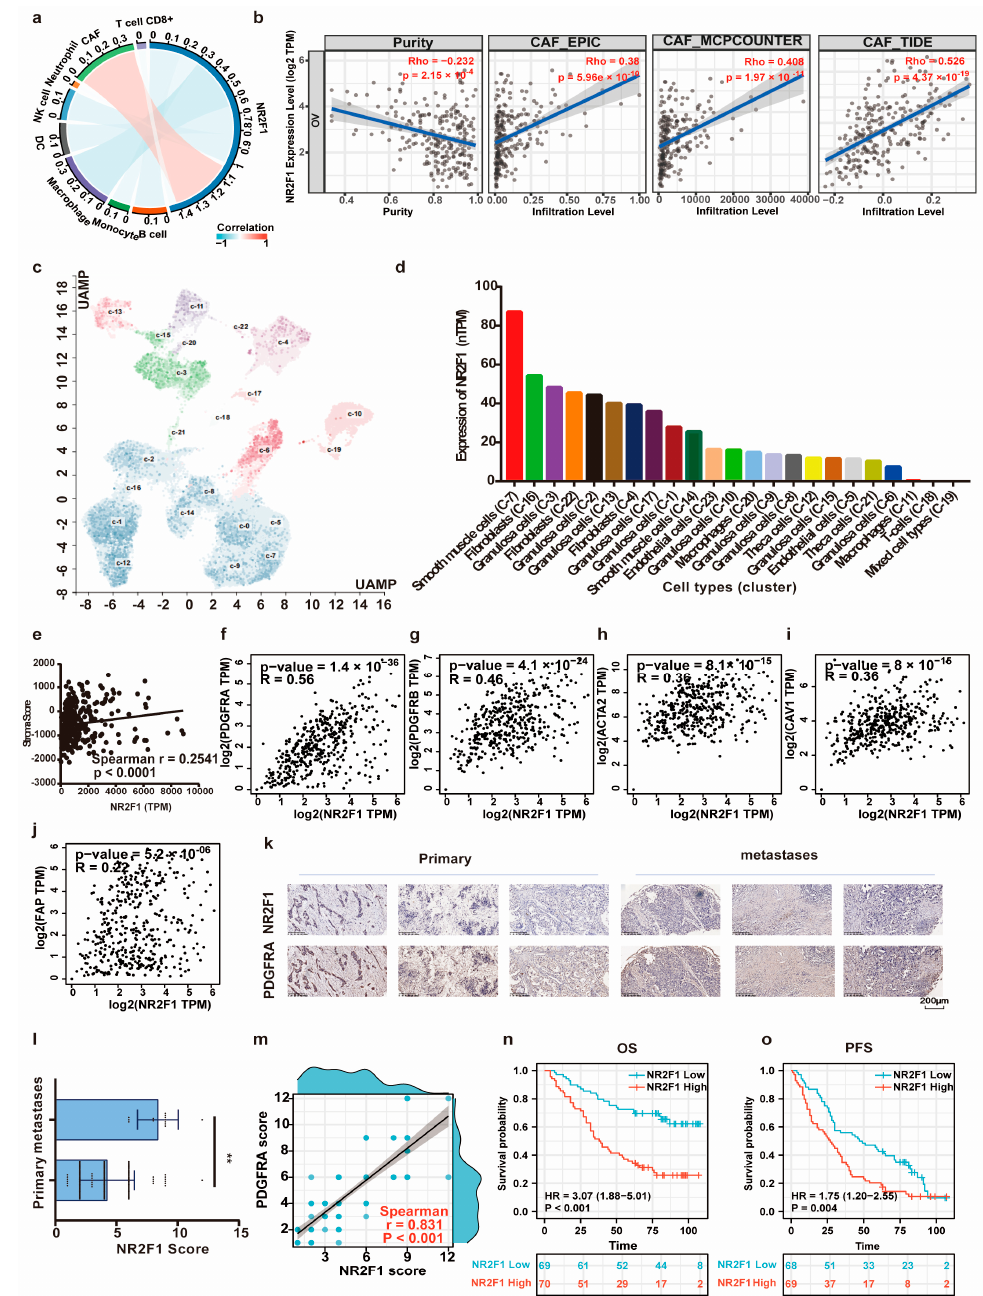
Figure 7. NR2F1 positively linked with cancer-associated fibroblast (CAF) infiltration. ( a ) The connection between NR2F1 and multiple kinds of tumor-infiltrating immune cells in OC by XCELL algorithm. ( b ) The association between NR2F1 and the infiltration of CAFs in OC according to EPIC, MCPCOUNTER, and TIDE algorithms. ( c , d ) The UMAP plot and the bar chart visualized NR2F1 expression in the single-cell types clusters in ovary tissues. ( e ) The relationship between NR2F1 with stromal score generated utilizing ESTIMATE algorithm, according to TCGA OC dataset. ( f – j ) The relationship between NR2F1 and markers of CAFs including PDGFRA, PDGFRB, ACTA2, CAV1, and FAP in GEPIA2. ( k ) Representative images of NR2F1 and PDGFRA protein expression in metastases and primary OC tissues. ( l ) NR2F1 was upregulated in metastases versus primary OC tissues. ** p < 0.01. ( m ) The relationship between NR2F1 and PDGFRA in all OC tissues. ( n , o ) Kaplan-Meier survival analyses of NR2F1 on OS, PFS in all OC